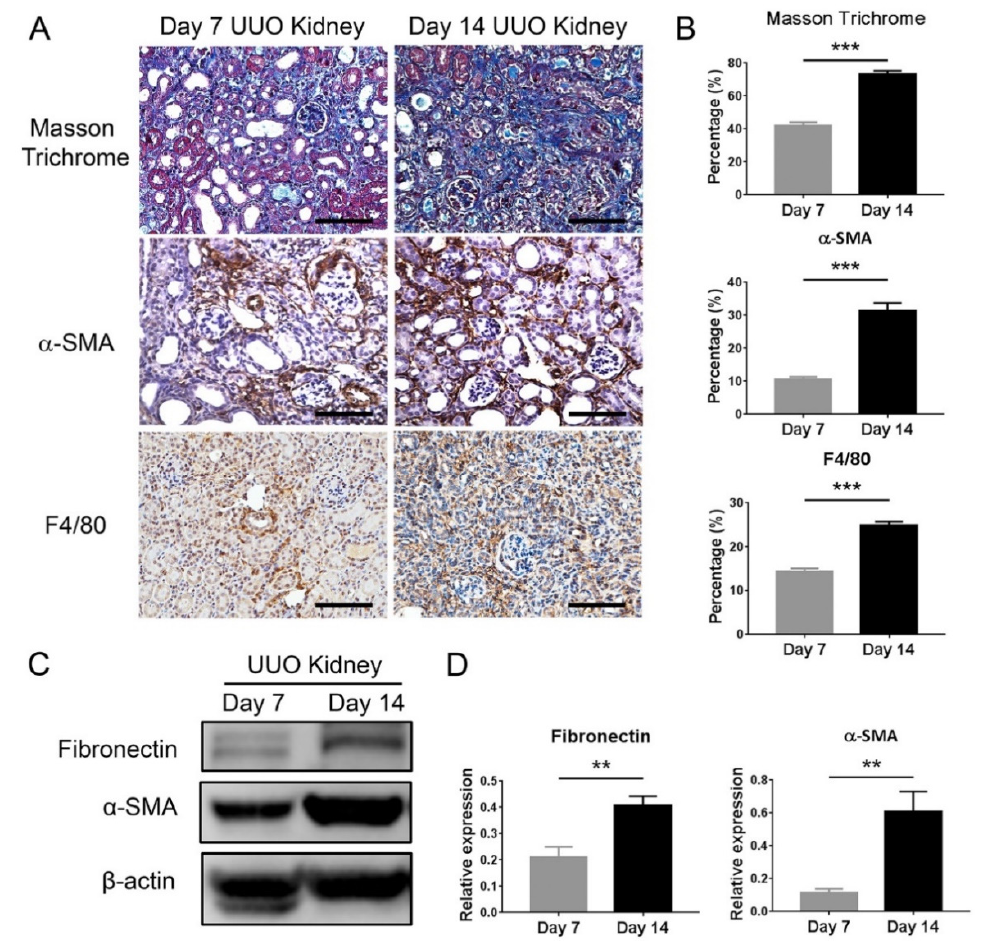
Figure 1. Macrophage infiltration correlates with renal interstitial fibrosis following a unilateral ureteral obstruction (UUO) injury. ( A ) Representative images of the Masson trichrome staining showed that the extent of fibrosis (blue staining) progressively increased in day 14 UUO kidneys as compared to day 7 ones. Immunohistochemistry demonstrated that more α -smooth muscle actin ( α -SMA)-positive myofibroblasts and F4 / 80-positive macrophages accumulated in day 14 UUO kidneys. Scale bar = 100 µ m. ( B ) Quantification of the fibrosis extent, α -SMA-positive and F4 / 80-positive areas. ** p < 0.01 and *** p < 0.001 by the unpaired Student’s t -test; n = 5 for each group. ( C ) Western blot analysis of fibronectin and α -SMA expression in day 7 and day 14 obstructed kidneys. β -actin served as the loading control. ( D ) Quantification of the Western blot analyses. ** p < 0.01 and *** p < 0.001 by the unpaired Student’s t -test; n = 5 for each group.